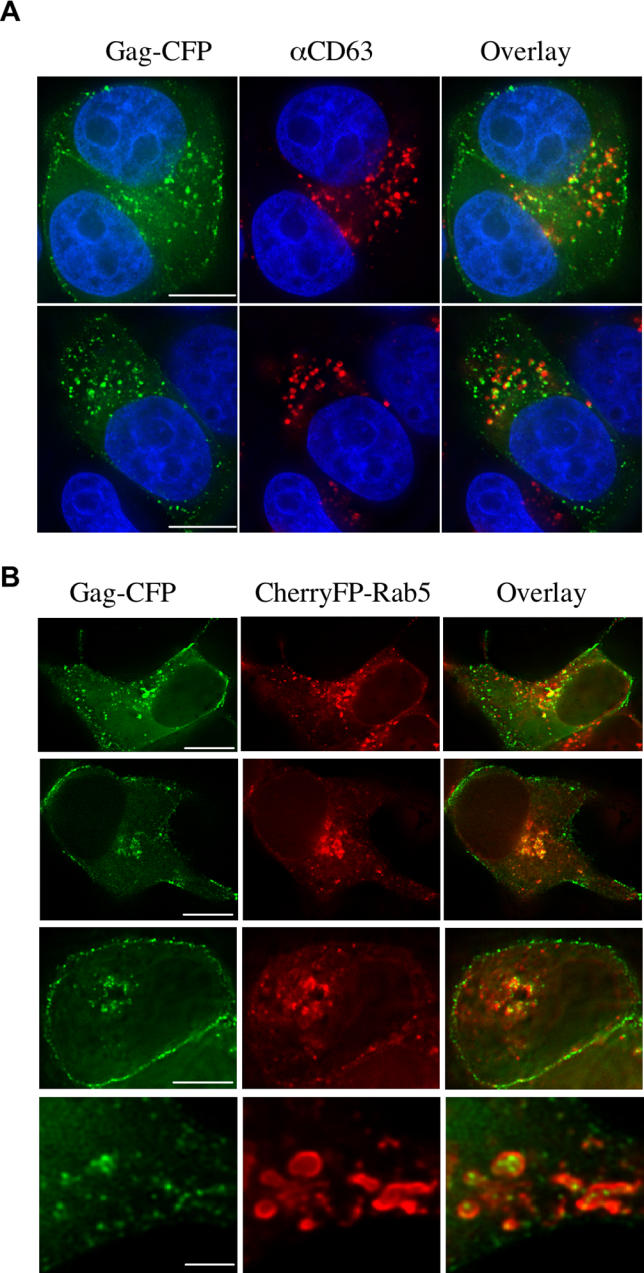
Intracellular HIV-1 Gag-CFP Partly Co-localizes with both Early and Late Endosomal Markers in HeLa Cells(A) HeLa cells expressing HIV-1 Gag-CFP (green) were fixed 18 h post-transfection and stained with a monoclonal antibody specific for human CD63, and a secondary anti-mouse Alexa-Fluor-588 conjugate (red). Nuclei were counter-stained with DAPI (blue).(B) HeLa cells expressing HIV-1 Gag-CFP (green) were co-transfected with CherryFP-Rab5a (red), a marker for early endosomal structures. Cells were fixed and images acquired at 18 h post-transfection. The lower set of images presented in (B) are shown at approximately 5-fold higher magnification to give a clearer indication of the juxtaposition of the HIV-1 Gag-CFP and CherryFP-Rab5a signals. White bars in the micrographs indicate a distance of 10 μm, except in the lower set of images in (B), where the bar indicates 2 μm